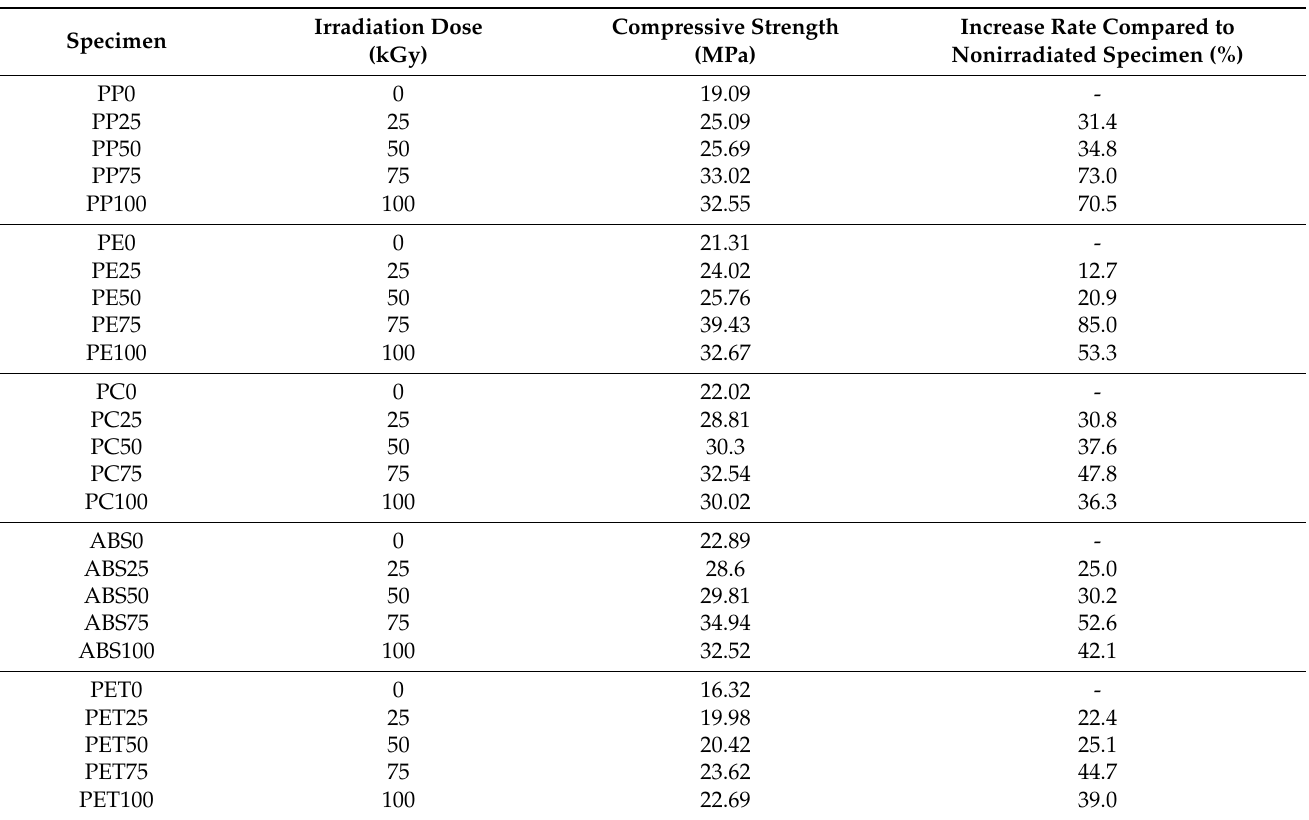
Table 7. Compressive strength for cementitious composites with irradiated plastic